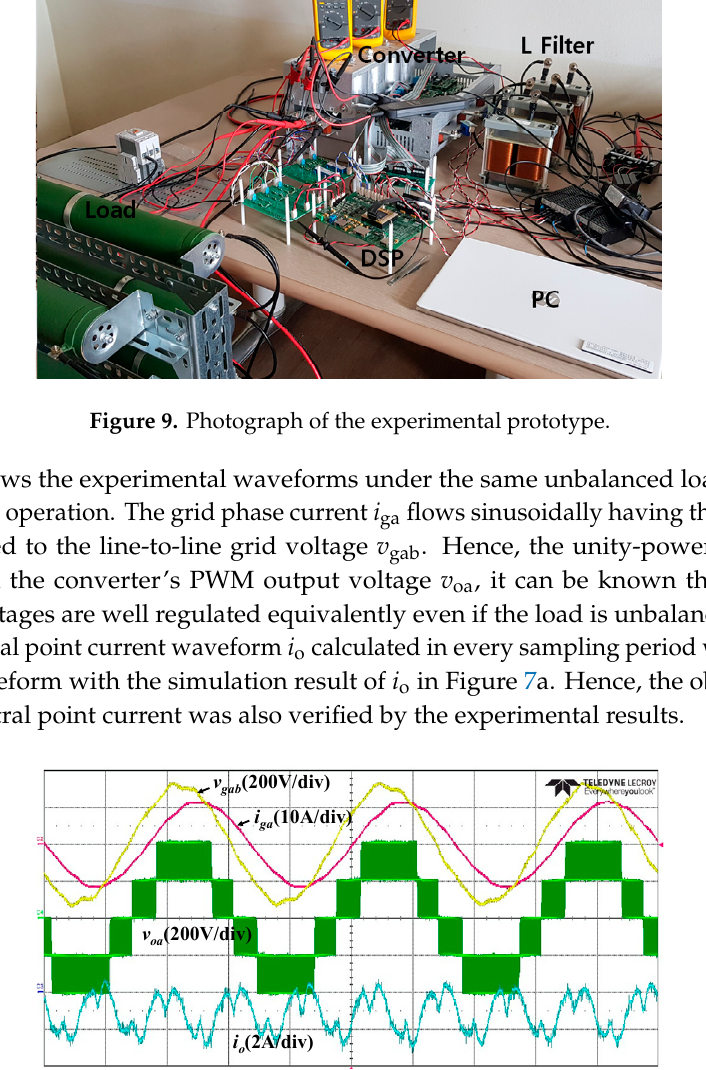
Figure 10. Experimental waveforms at unity power factor operation under unbalanced load conditions.